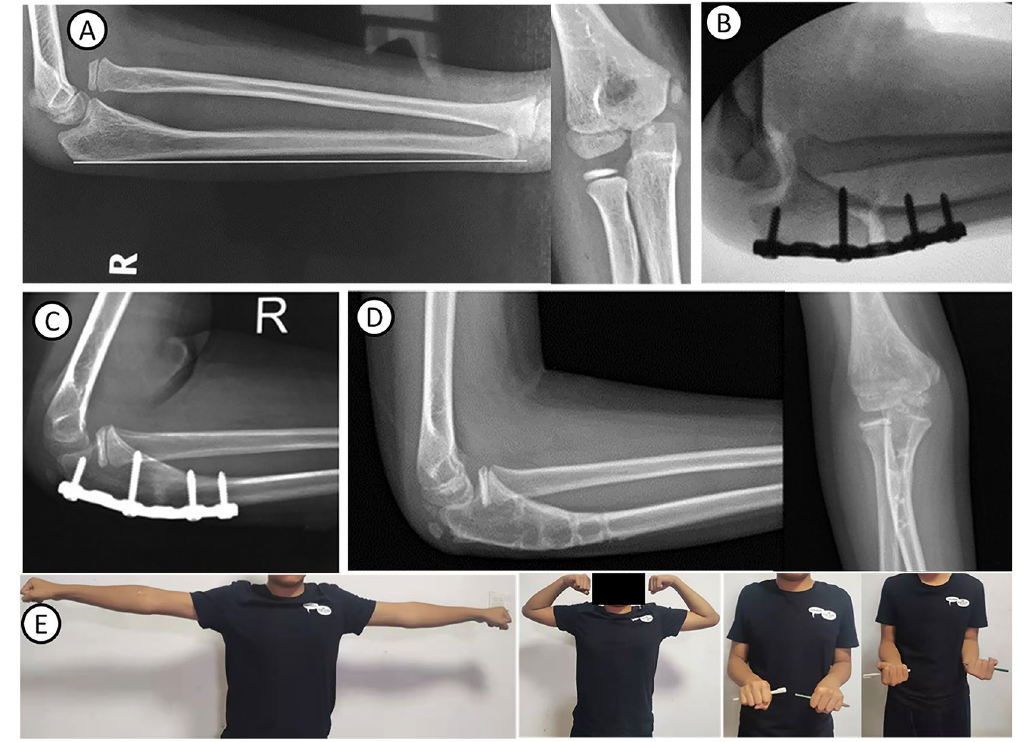
Figure 3. Typical case 2: An 8-year-old boy with right missed Monteggia fracture. ( A ) Bado type I, ulna bow sign is located at the distal end of ulna (group B). ( B ) Reverse angulation 12° during operation, radial head reduction. ( C ) At 5 months after operation, the radial head is in place, and the osteotomy end has completely healed. ( D ) At 1 year after operation, the radial head is in place. ( E ) The elbow joint function was good 4 years after operation.